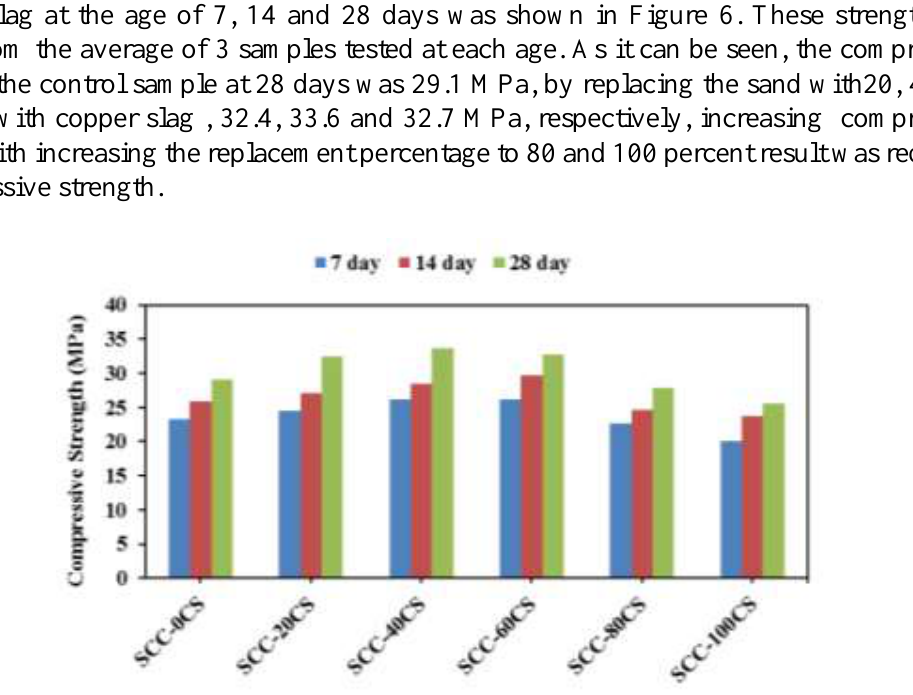
Figure 6. Variation of 7, 14 and 28 day compressive strength for various percentages of copper slag